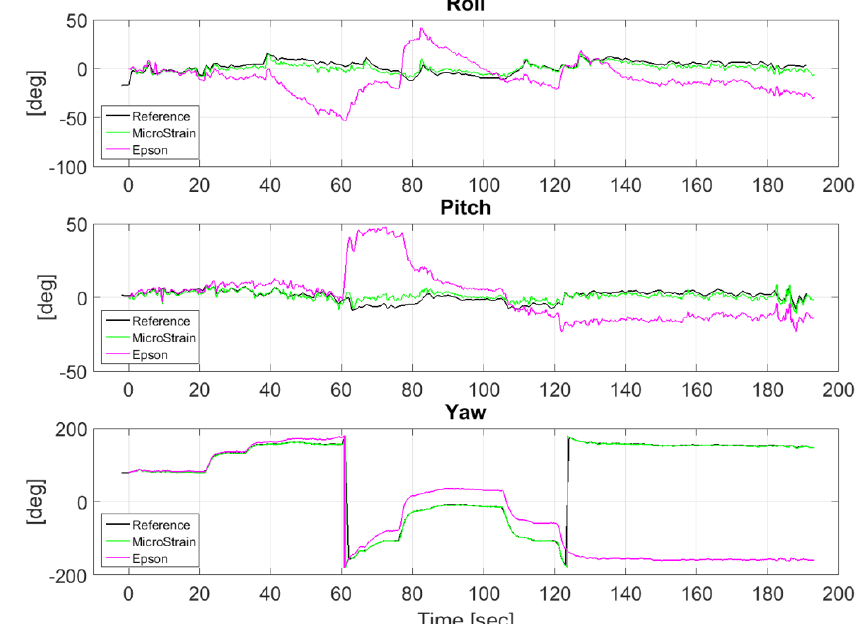
Figure 4. Euler angles obtained from GSP/IMU data integration using modified EKF and Nikon images